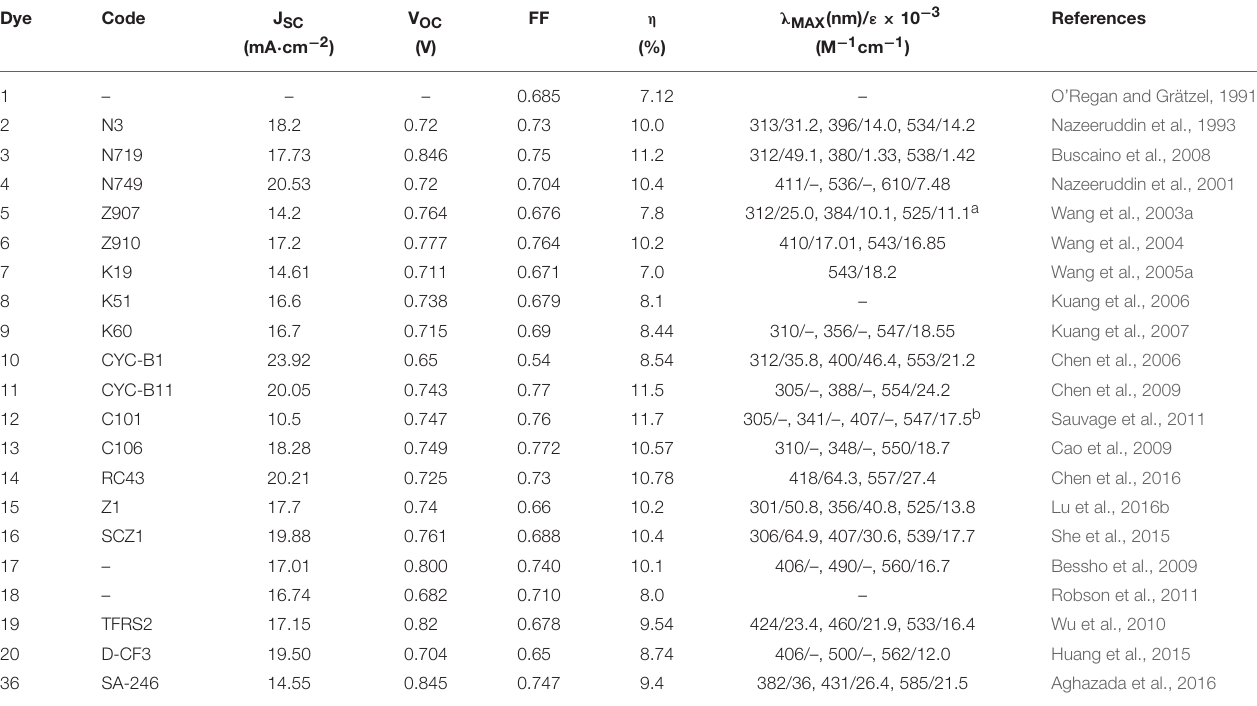
TABLE 1 | Photovoltaics parameters of DSSC sensitized Ru-based sensitizers dyes 1–20 and 36. Dye